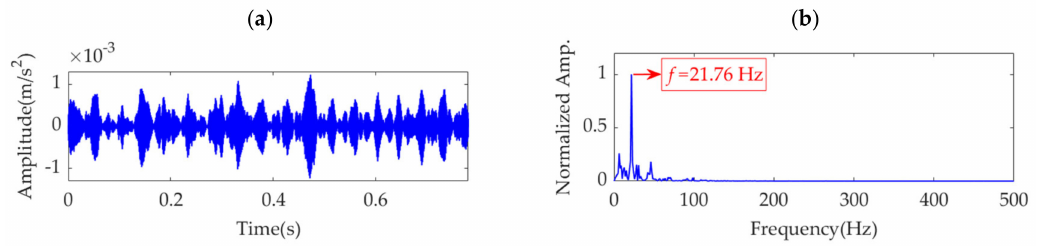
Figure 19. Target mode obtained by VMD: ( a ) time–domain waveform and ( b ) SES.